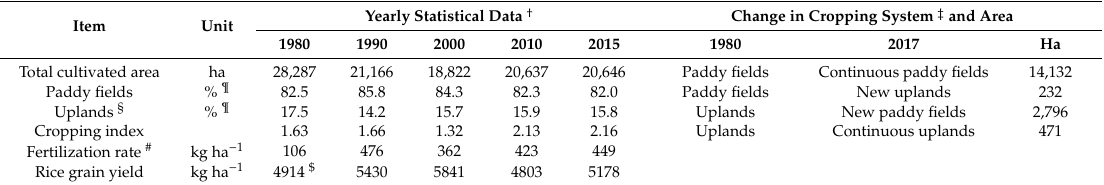
Table 1. Historical changes in cultivated land area and cropping